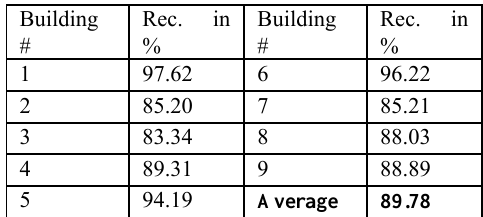
Table 1: Assessment of the footprints reconstruction